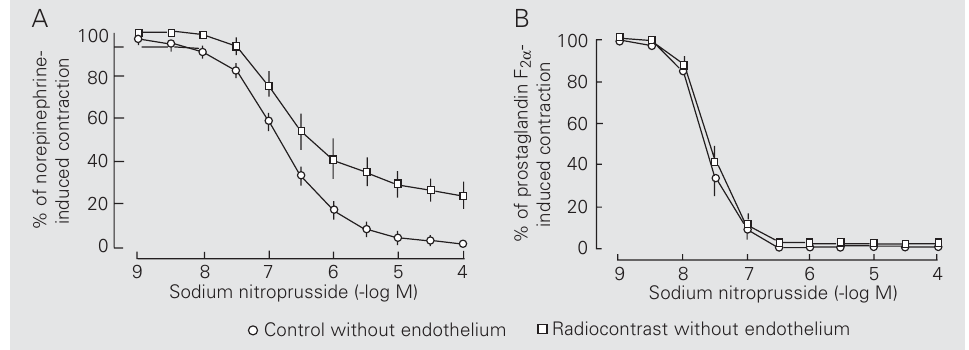
Figure 3. Relaxation in response to sodium nitroprusside by the canine renal artery. Canine renal arteries were exposed to ionic radiocontrast (1 ml per 25 ml of Krebs solution) and contracted with norepinephrine or prostaglan- din F 2 α . When the norepinephrine contraction was stable, arteries were exposed to increasing concentrations of sodium nitroprusside. A , Canine renal arteries exposed to ionic radiocontrast and contracted with norepinephrine (N = 6). B , Canine renal arteries exposed to ionic radiocontrast and contracted with prostaglandin F 2 α . Data are reported as means ± SEM.